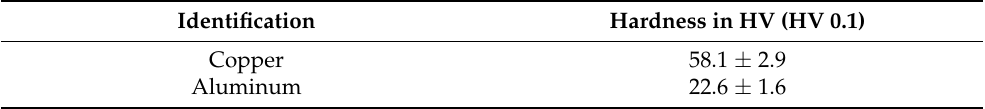
Table 6. Hardness measurements of the base material.